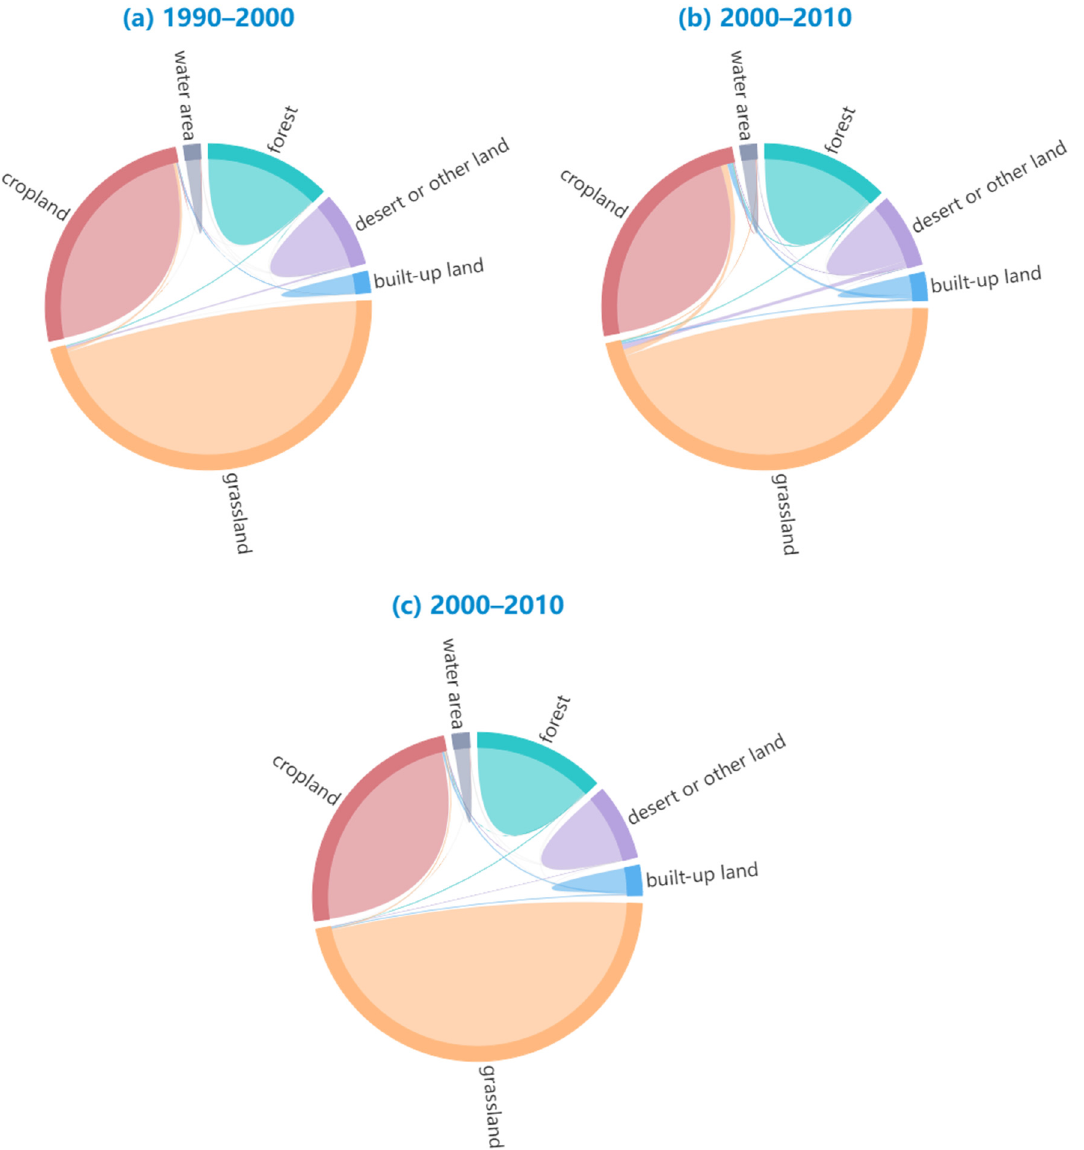
Figure 3. Land cover transfer matrix of YRB between 1990 and 2000 ( a ), 2000 and 2010 ( b ), and 2010 and 2020 ( c ).